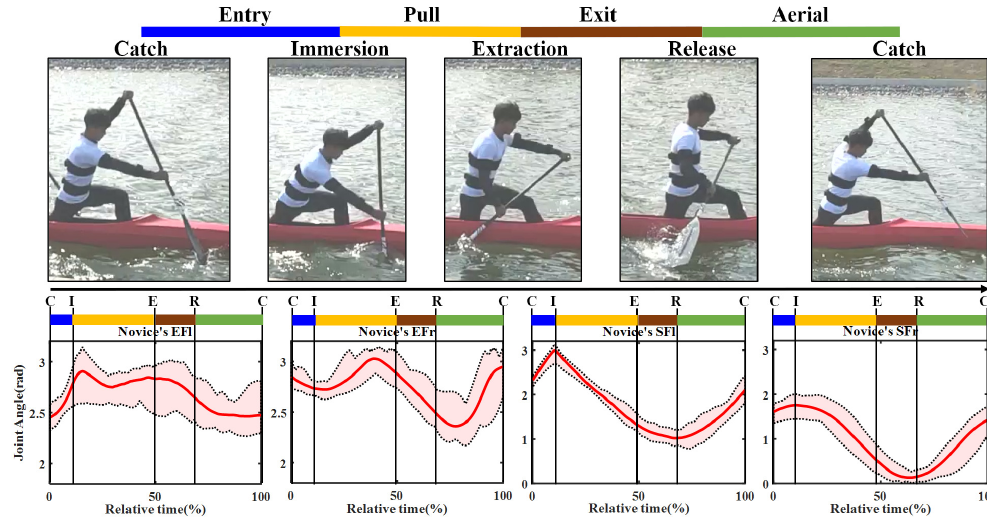
Figure 15. The joint flexion angle extension variation of novice on both sides of the body.